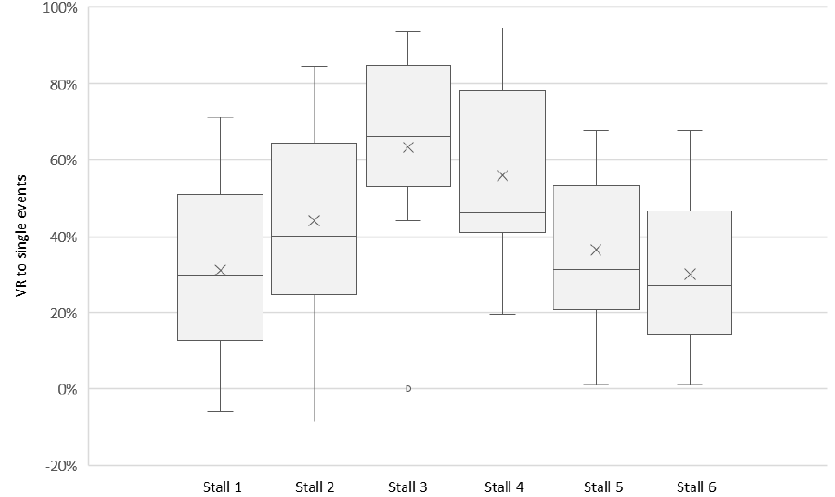
Figure 5. Variation in VR event to experimental stalls 1–6 displayed by quantiles, minimum and maximum values and outliers as a box-and-whisker plot.